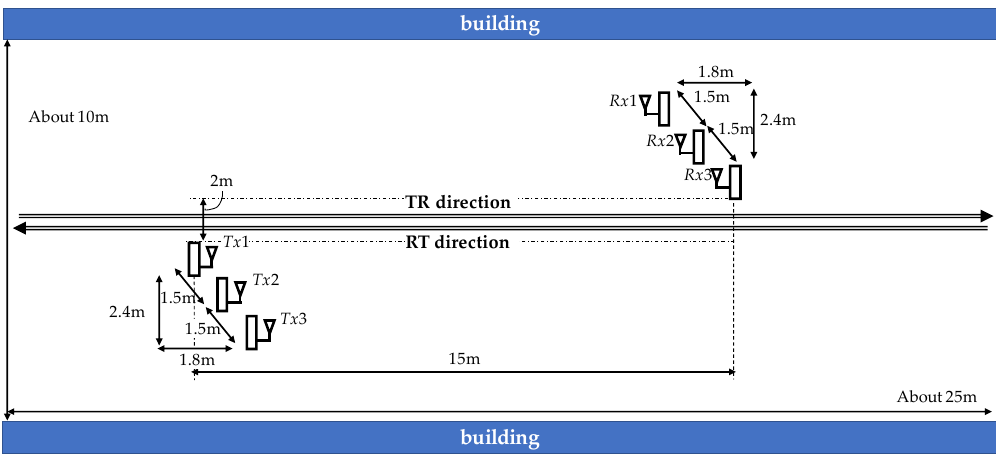
Figure 9. Antenna deployment. Figure 9. Antenna